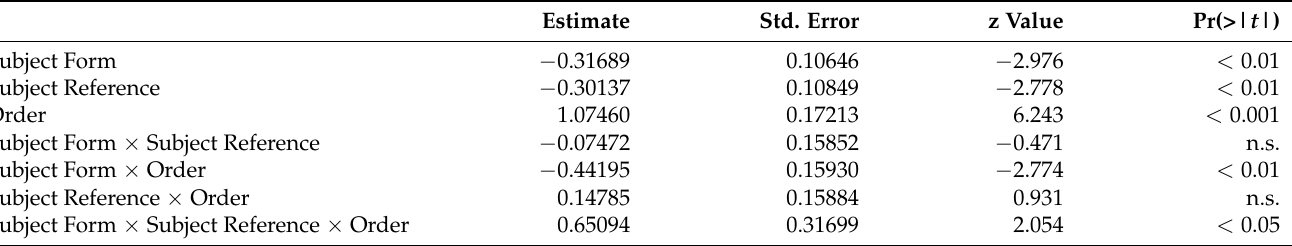
Figure 2. Mean acceptability in Experiment 2. Error bars show 95% confidence intervals. Table 4. Ordinal mixed model for Experiment